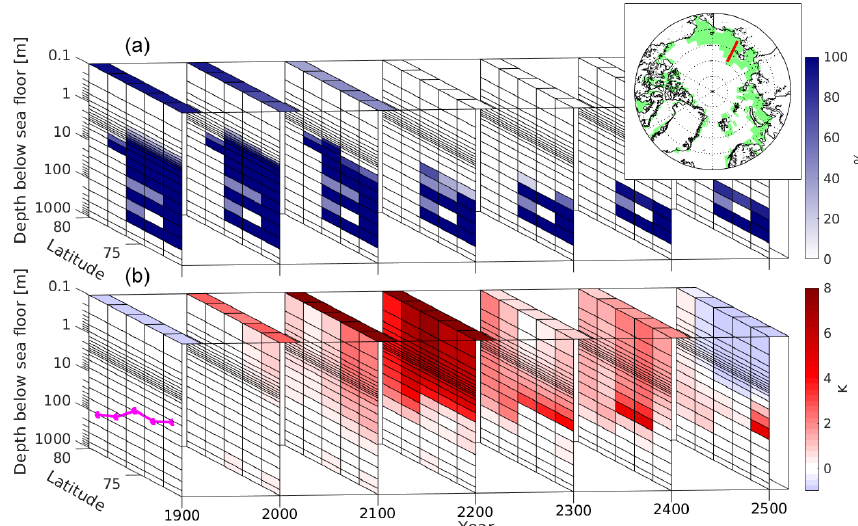
Figure 7. SSPF ice saturation ( a , lat–depth planes), sea ice concentration ( a , lat–time planes), sediment temperature change ( b , lat–depth planes), and atmospheric 2m temperature change ( b , lat–time planes) along a section across the East Siberian Shelf (153 ◦ E, shown on the insert in a ) for different time periods. In (b) time slice at 1900 represents the 1850–1900 change, and subsequent slices represent the changes relative to the slice before. Black lines at constant depth are model layer boundaries. Magenta line shows the water depth along the section. Shown are (differences between) yearly averages.